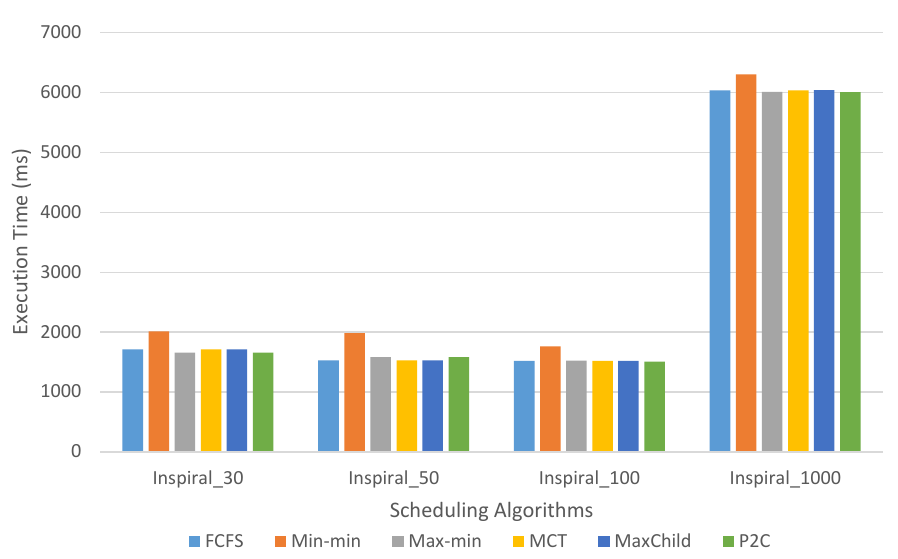
Figure 15. Comparison of execution time for inspiral workflow.